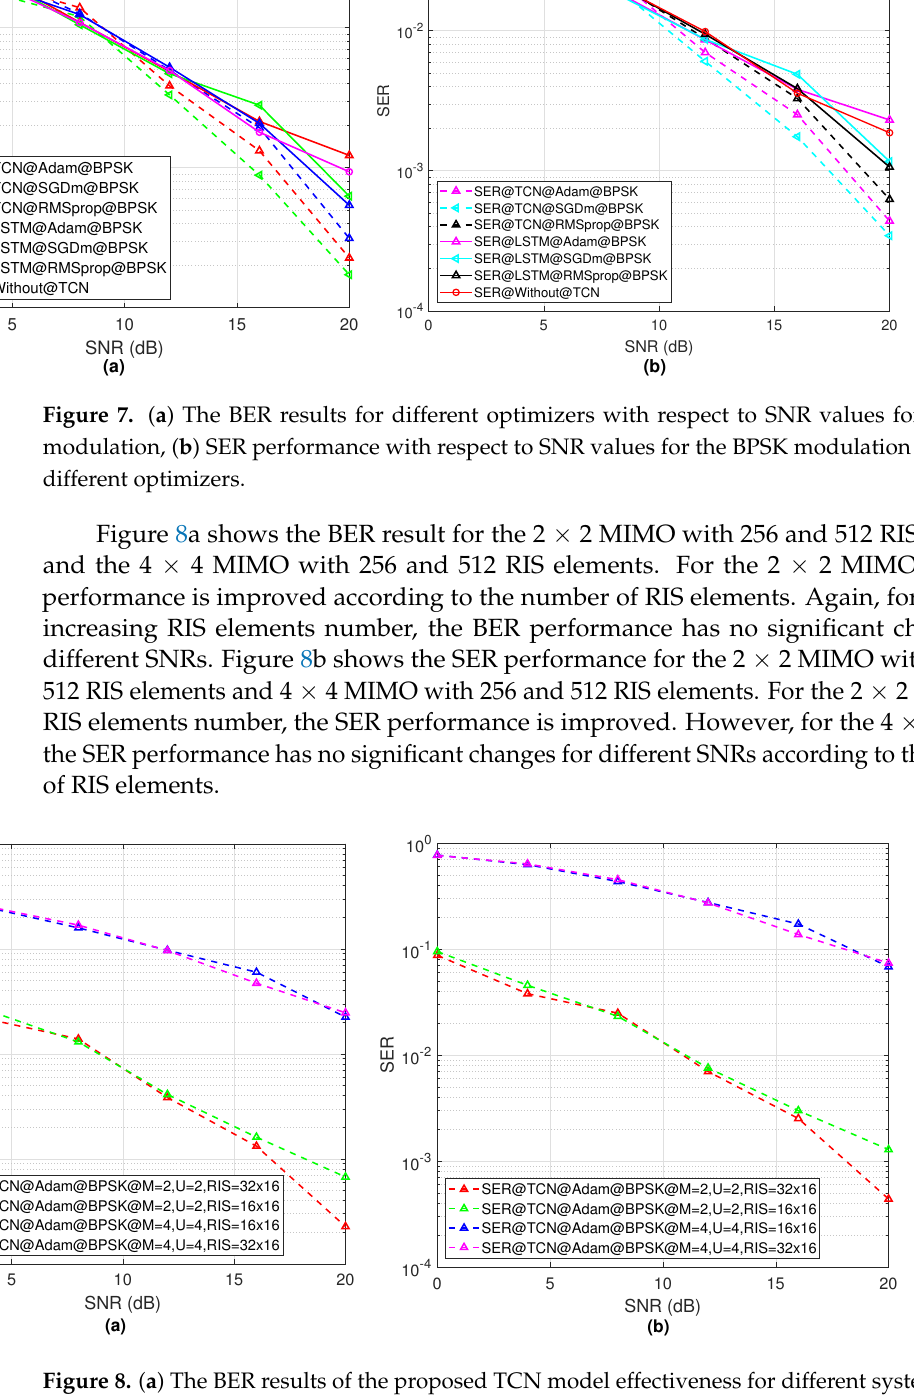
Figure 8. ( a ) The BER results of the proposed TCN model effectiveness for different system configu- rations, ( b ) SER results of the proposed TCN model effectiveness for different system